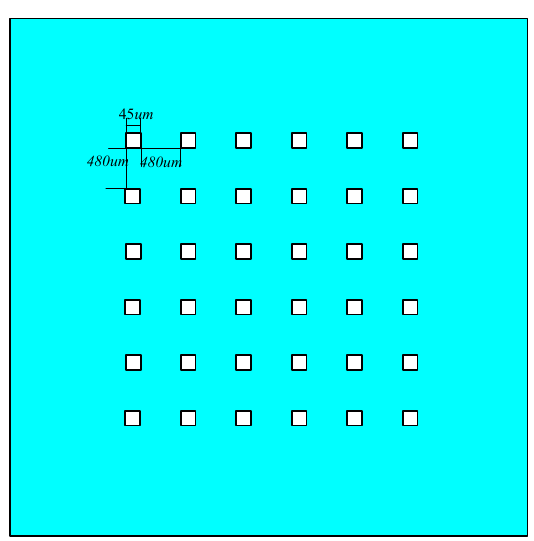
Figure 2. 6 × 6 multi-aperture mask.